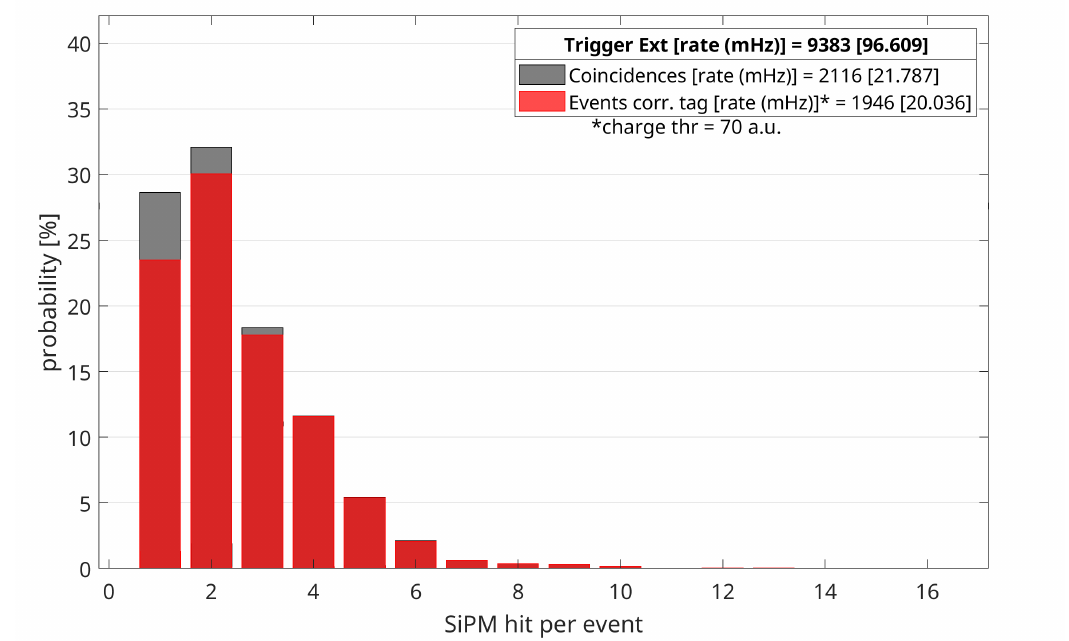
Figure 6. Bar plot of the probability of hitting a certain number of SiPM for the acquisition in UP configuration and SDT = 254. Red and grey bars refers to the probability that n SiPMs are stricken with a measured charge greater than threshold, equal to 70 a.u. in this example. Table 1. VMM chip SDT (common threshold for all channels) values set for test measurements with Cherenkov-tag prototype and corresponding acquisition time for both configurations, UP and DOWN. SDT